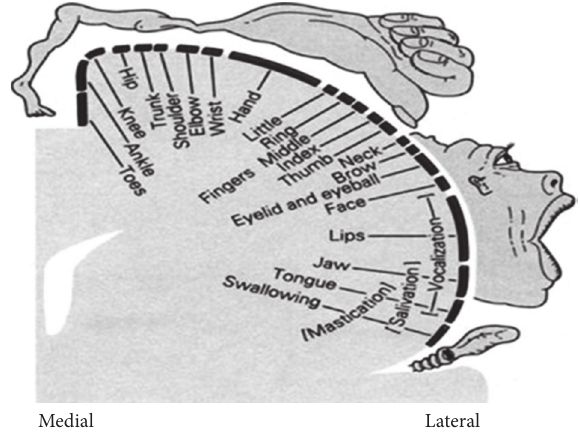
Figure 4: Penfield and Rasmussen’s